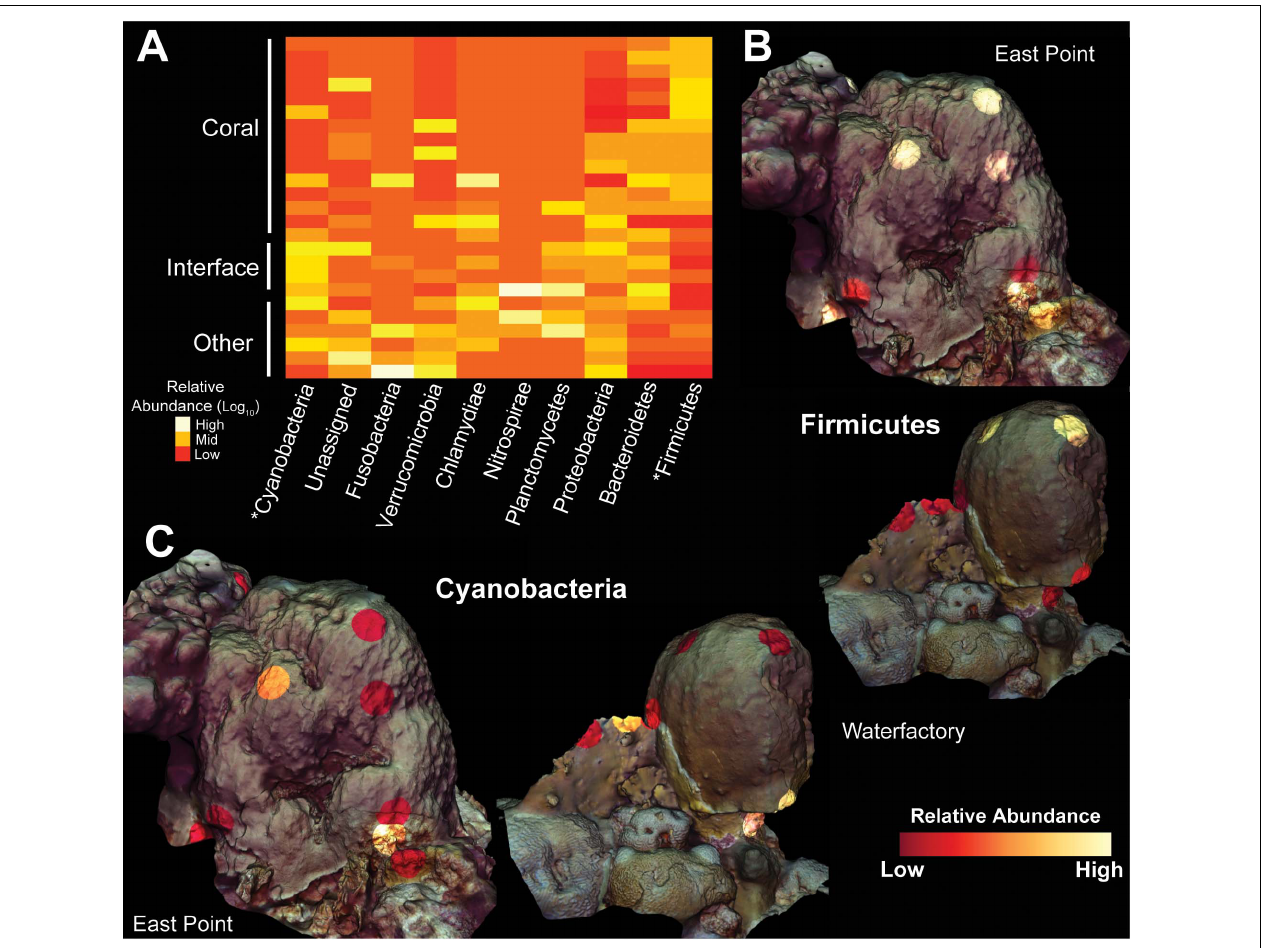
FIGURE 4 | Heatmap and 3D cartography of bacterial phyla from Orbicella faveolata colonies, competitors and interfaces. (A) Heatmap of phyla selected from the supervised random forests analysis. Relative abundances are log-transformed and colors are normalized to columns with red representing the lowest relative abundance and white representing the highest. Asterisks highlight phyla shown in 3D models. 3D coral models mapped with the relative abundances of (B) Firmicutes and (C) Cyanobacteria from both sampling sites. The relative abundance of Firmicutes ranges from 0.21–93.5% at East Point and 0.0–89.7% at Water Factory. For Cyanobacteria, the relative abundance ranges from 0.0–14.4% at East Point and 0.0–0.49% at Water